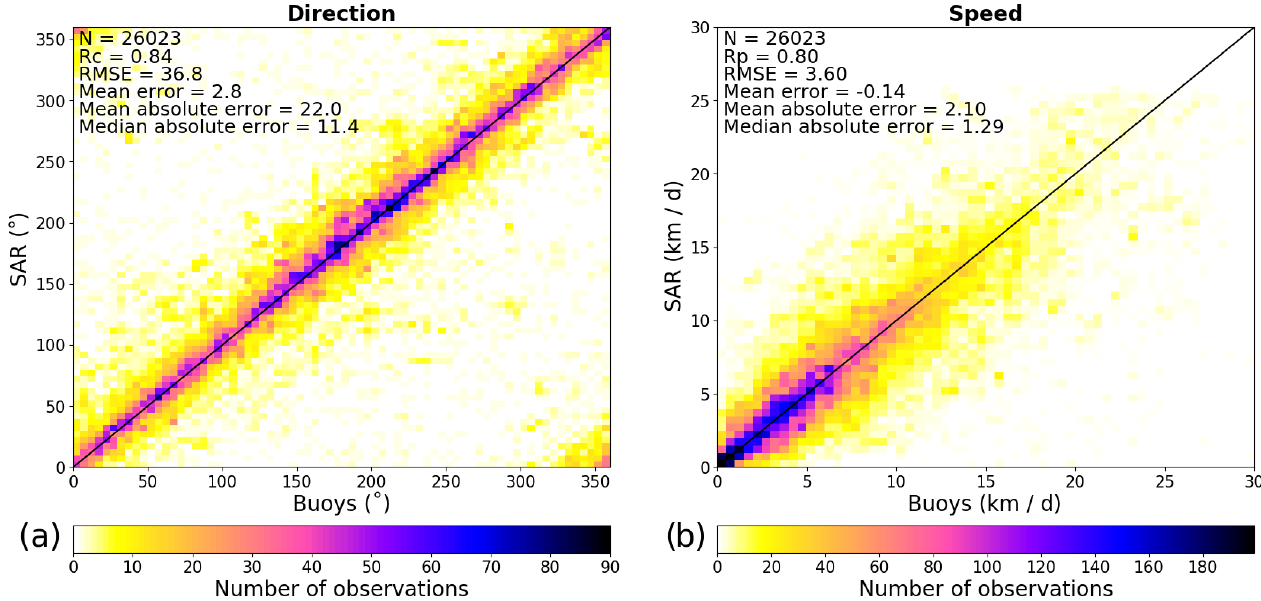
Figure 2. Evaluation of the Copernicus Marine Service (CMEMS) SEAICE_GLO_SEAICE_L4_NRT_OBSERVATIONS_011_006 product (MOSAIC version 2.0) for the sea ice drift direction (a) and speed (b) during the period from January 2018 to December 2020. The axes are bounded to 30kmd − 1 for the speed for clarity, but the speed of 73 buoys exceeds 30kmd − 1 . However, these buoys were taken into account when calculating the statistics shown in the figures ( N – number of samples; R c – circular correlation coefficient; R p – Pearson correlation coefficient; RMSE – root mean square error). The color scales represent the number of observations in each bin of 5 ◦ for the direction and 0.5kmd − 1 for the